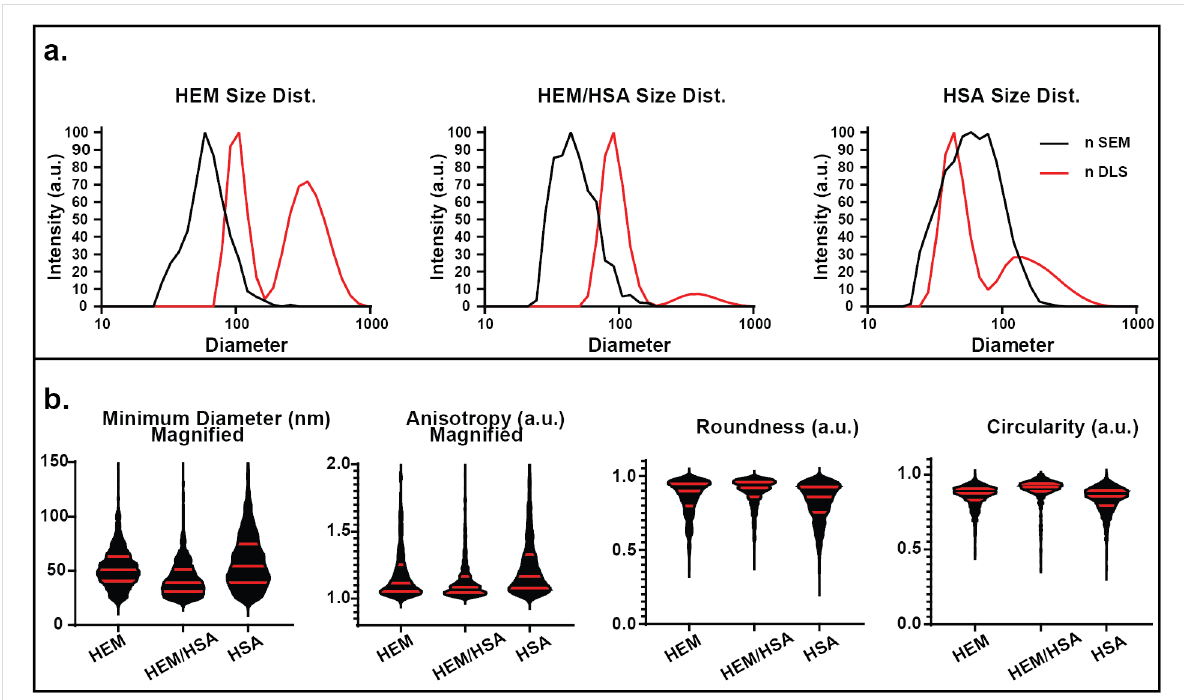
Figure 2: Size distribution and secondary geometric factors of HEM SPNPs based on SEM and DLS analysis. (a) Number distributions of SPNP sizes as obtained by SEM and DLS. (b) Violin graphs of minimum diameter, anisotropy, circularity and roundness (median and interquartile ranges are presented by red